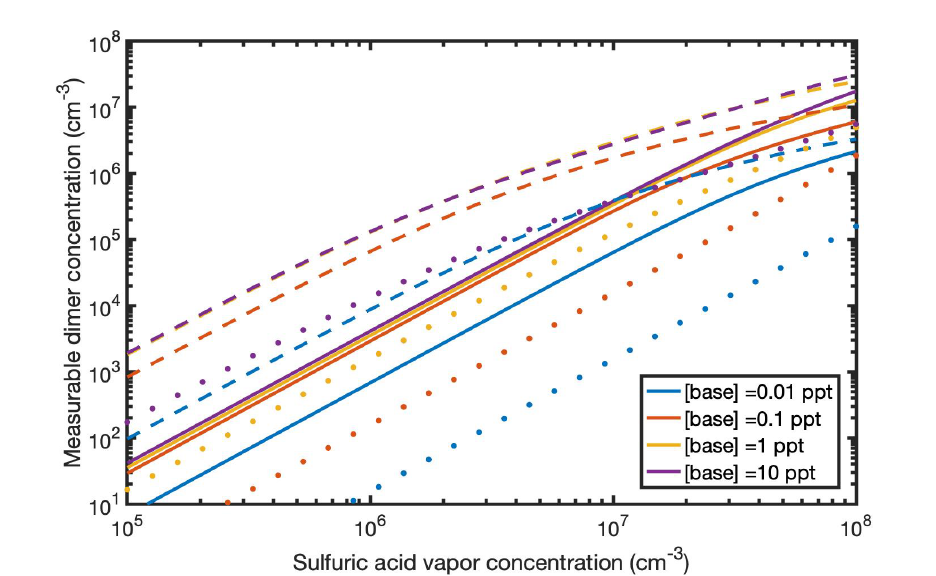
Figure 9. Steady-state concentrations of SA dimers with TMAO (solid lines), GUA (dashed lines), and DMA (dots) as a function of SA monomer concentration at 298.15 K. Note: 1 ppt